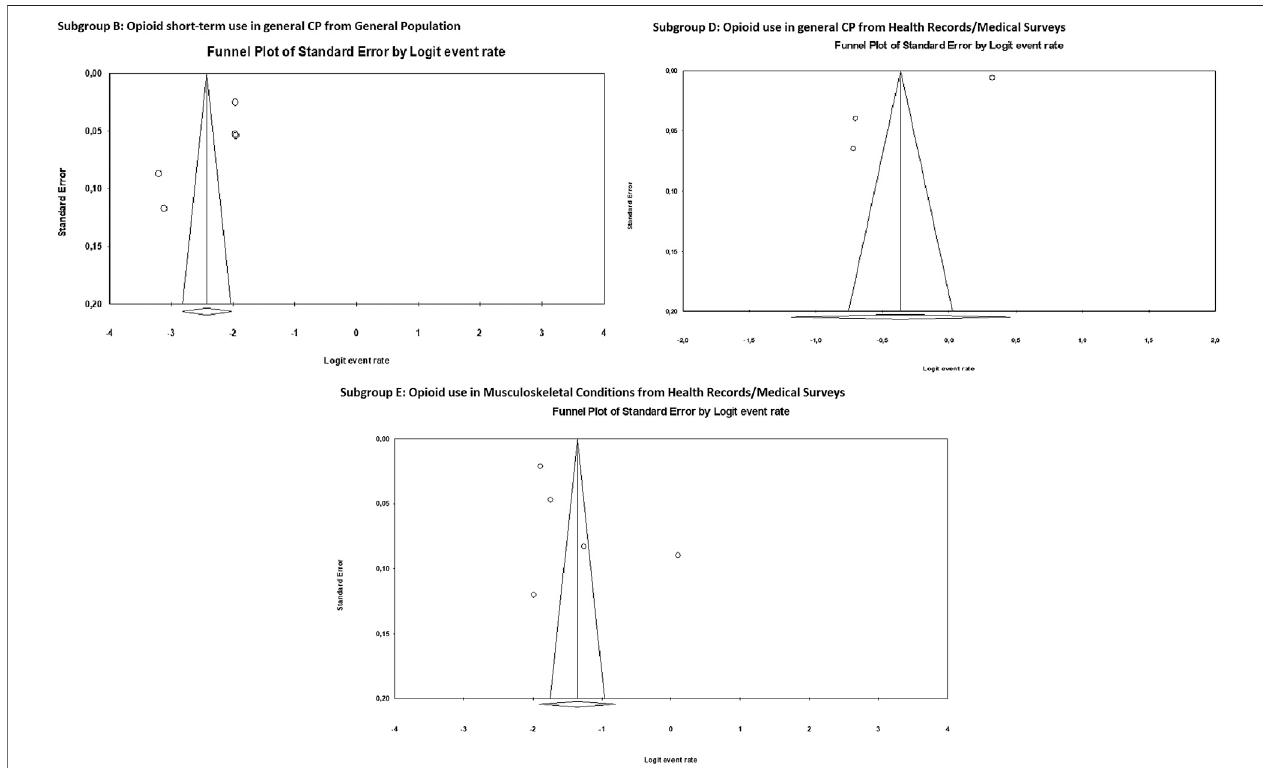
FIGURE 3 | Publication bias. Funnel plots of the subgroups B, D and E of the meta-analyses.